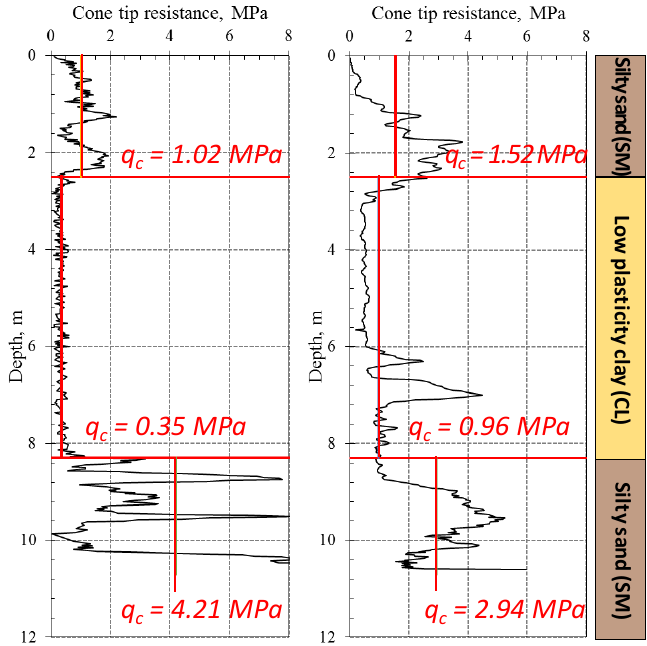
Figure 1. Cone tip resistance (q c ) profiles.